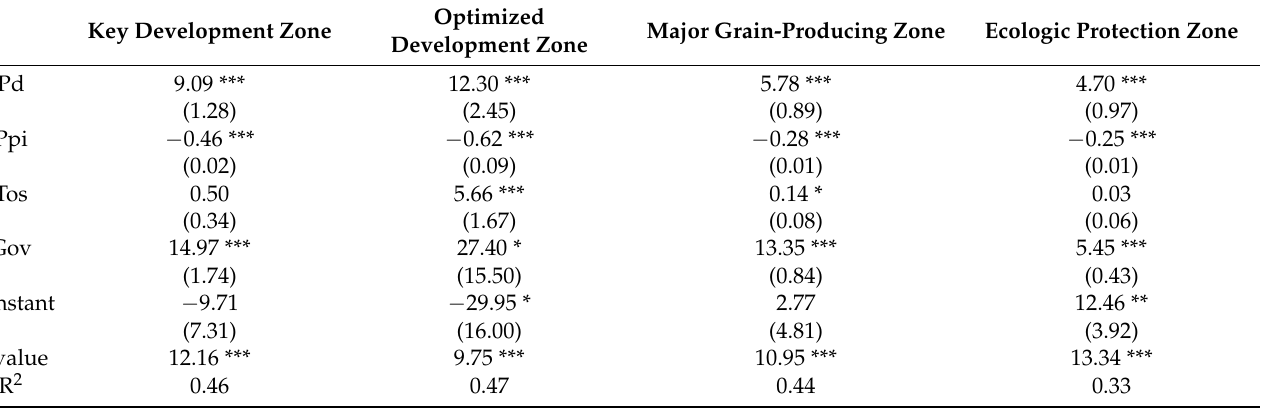
Table 5. Regression results of different functional